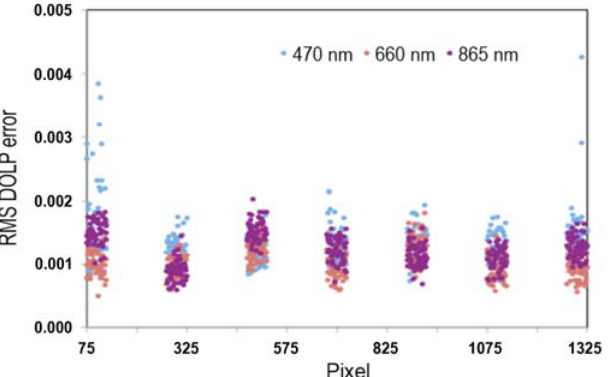
Figure 2. Root-mean-squared (RMS) error in degree of linear polarization (DOLP), calculated as deviations from 1.000 as a high-extinction polarizer is rotated in 10° steps in front of the GroundMSPI camera. Polarimetric calibration is done in segments, since the light-emitting diode (LED) illumination covers only a portion of the camera field of view (FOV). Results from seven segments across the FOV are shown